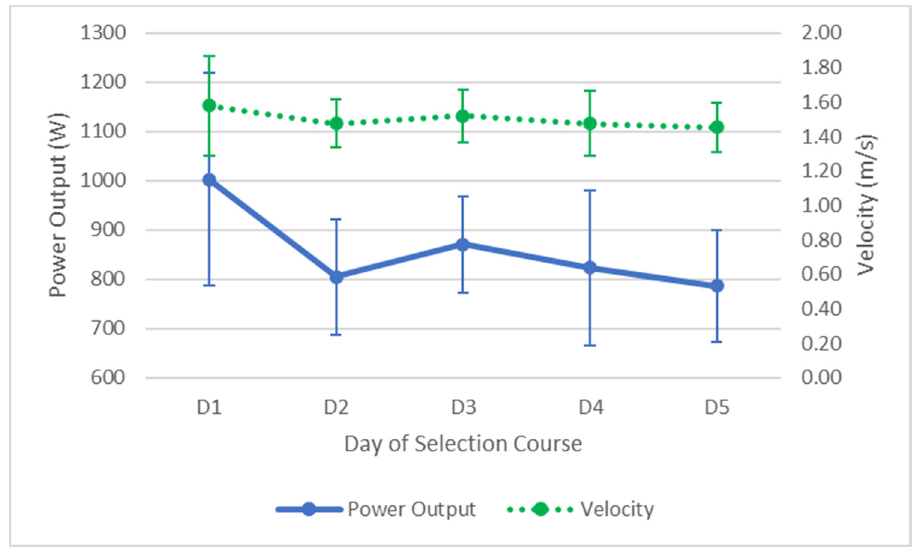
Figure 6. Average changes (±SD) in bench throw performance over the five days. Solid line represents power output, dotted line represents velocity.